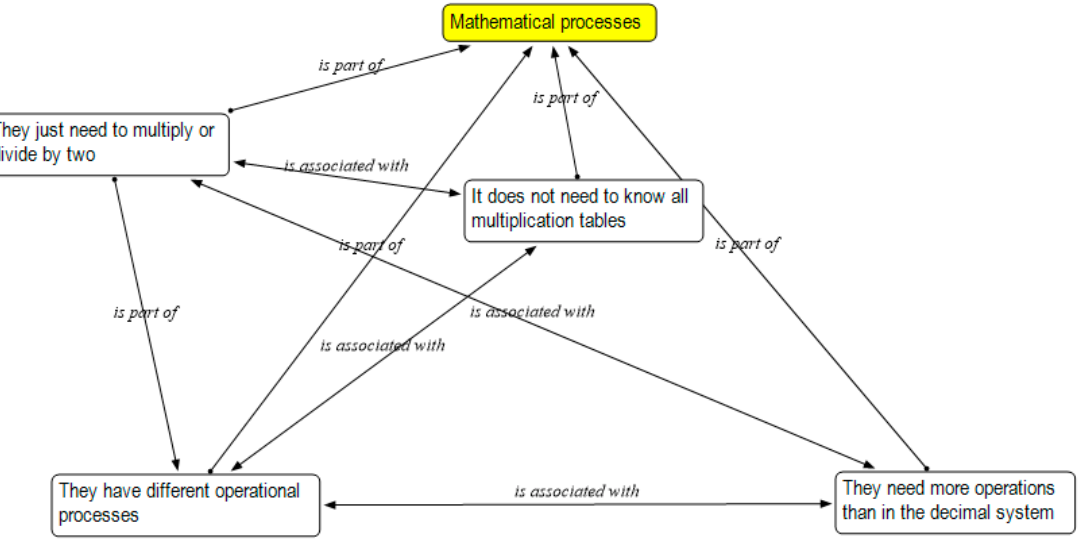
Figure 5. Category of “procedure and application” regarding differences.